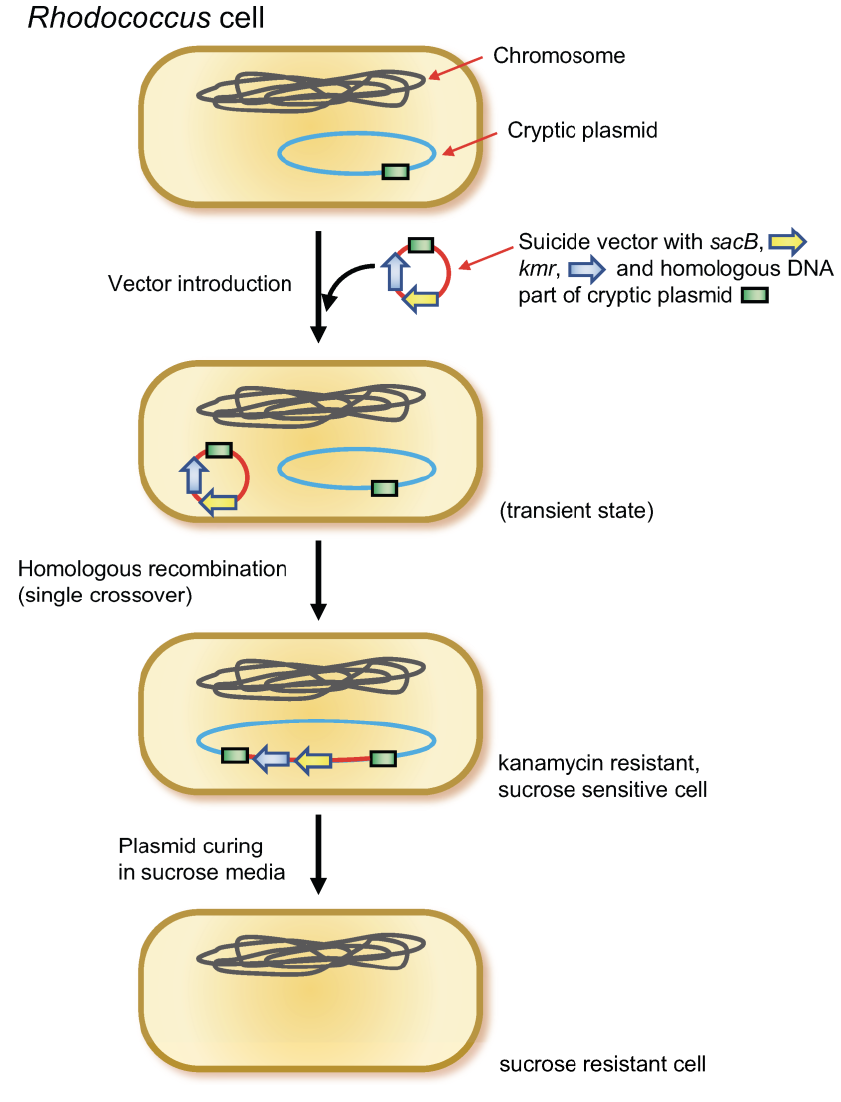
Figure 1. Plasmid-curing method using sacB gene. Suicide vector with sacB gene was integrated to the cryptic plasmid to be cured by homologous recombination. Subsequently, the plasmid was cured by cultivating in a media containing 20% sucrose.